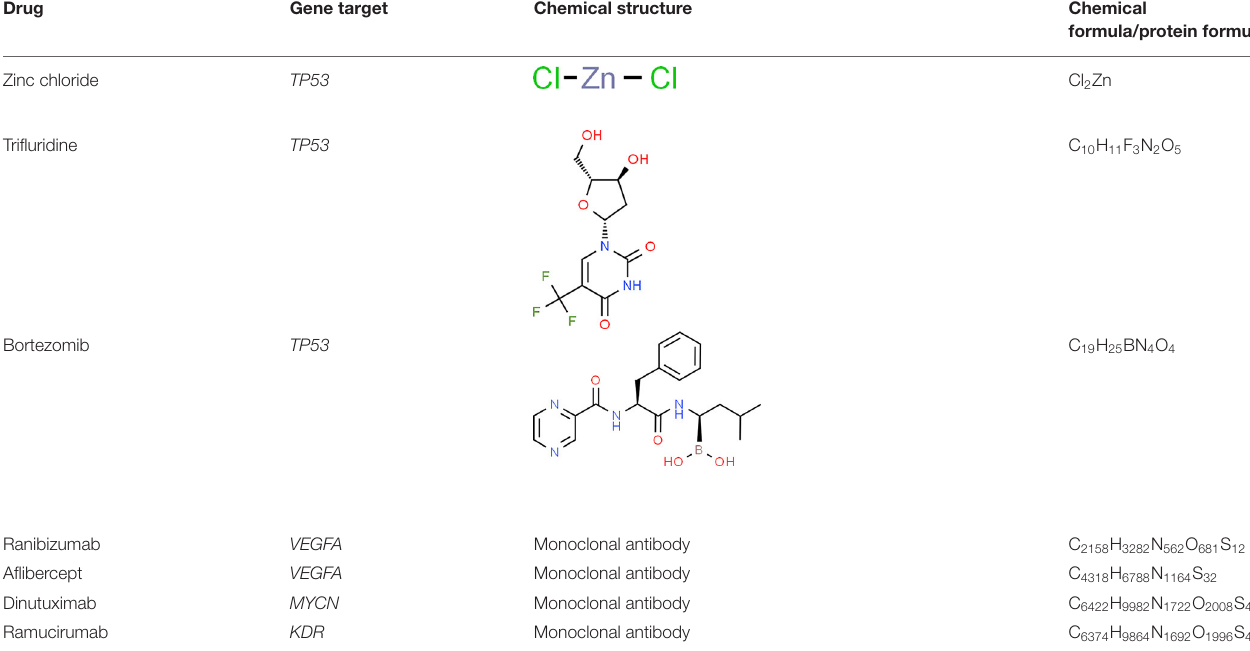
Drug Gene target Chemical structure Chemical